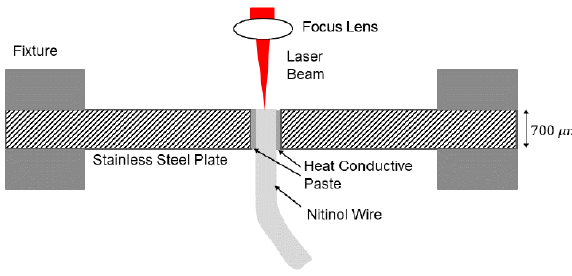
Figure 7: Proposed setup for drilling thin nitinol wires to restore semi-infinite material condition.